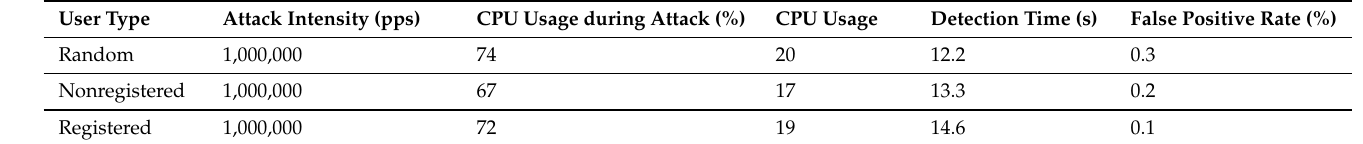
Table 2. Performance measurements during the attack and defense